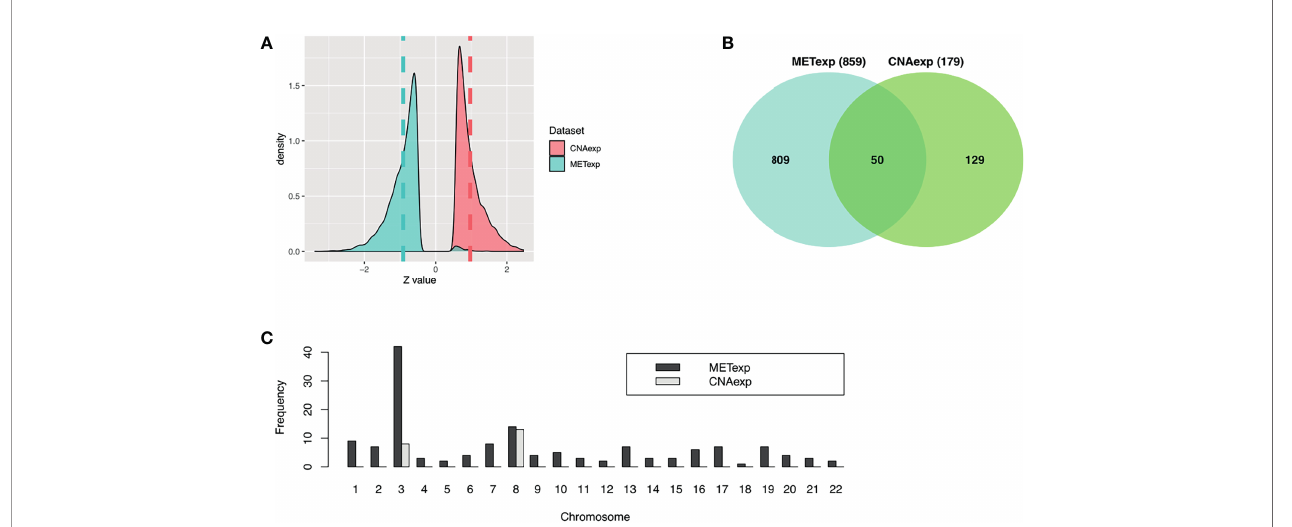
FIGURE 2 | Characteristics of CNAexp and METexp in UM. (A) Two Z -score distributions showed two associations of MET or CNA with their respective mRNA. (B) Intersection between 859 METexp genes and 179 CNAexp genes. (C) Side-by-side bar chart showed the frequency of the CNAexp or METexp genes against the total count of genes in each chromosome arm. CNA, DNA copy number aberrations; MET, epigenetic DNA